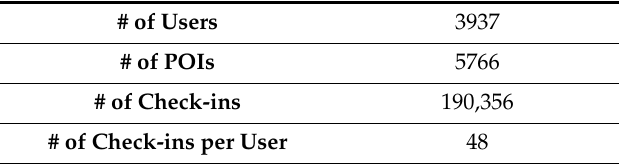
Table 2. Statistics of the data